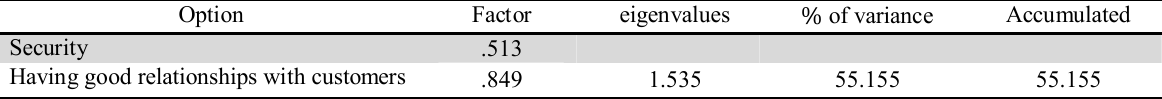
The summary of factors associated with targeting appropriate market Option Factor eigenvalues % of variance Accumulated Security .513 Having good relationships with